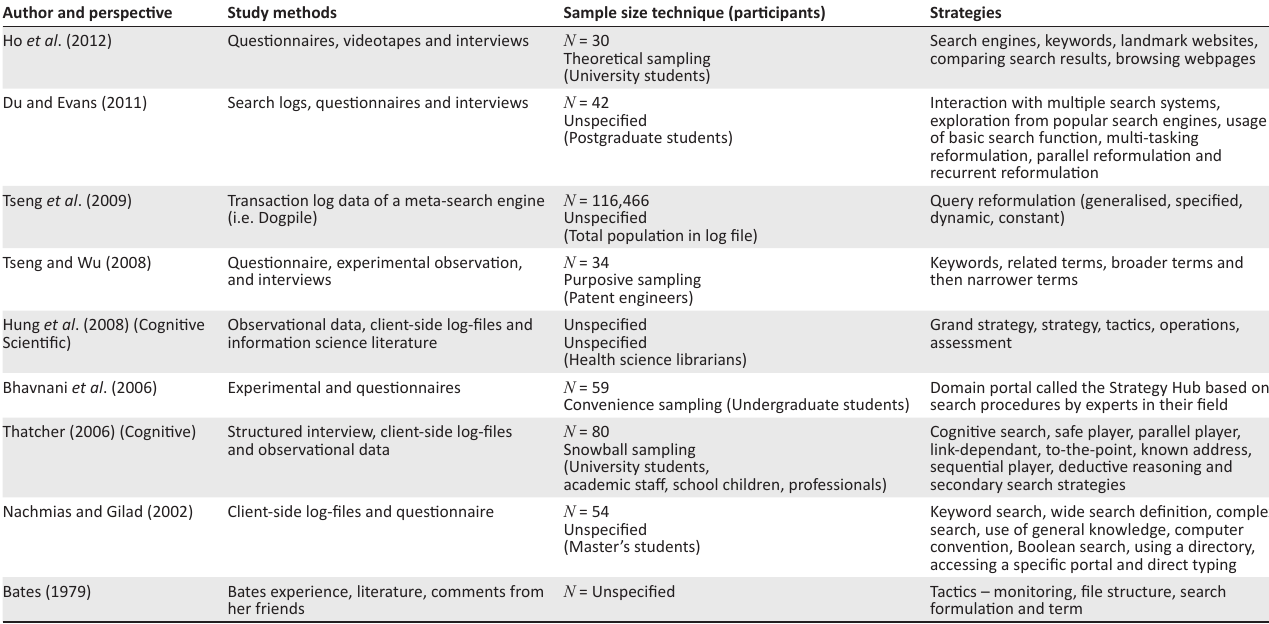
TABLE 1: Studies investigating Web-searching